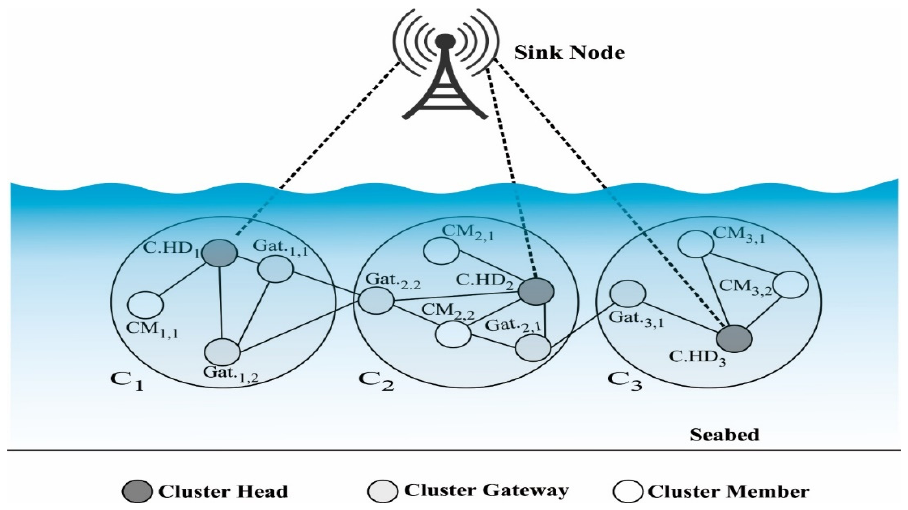
Figure 1. Overview of cluster based UWSN.